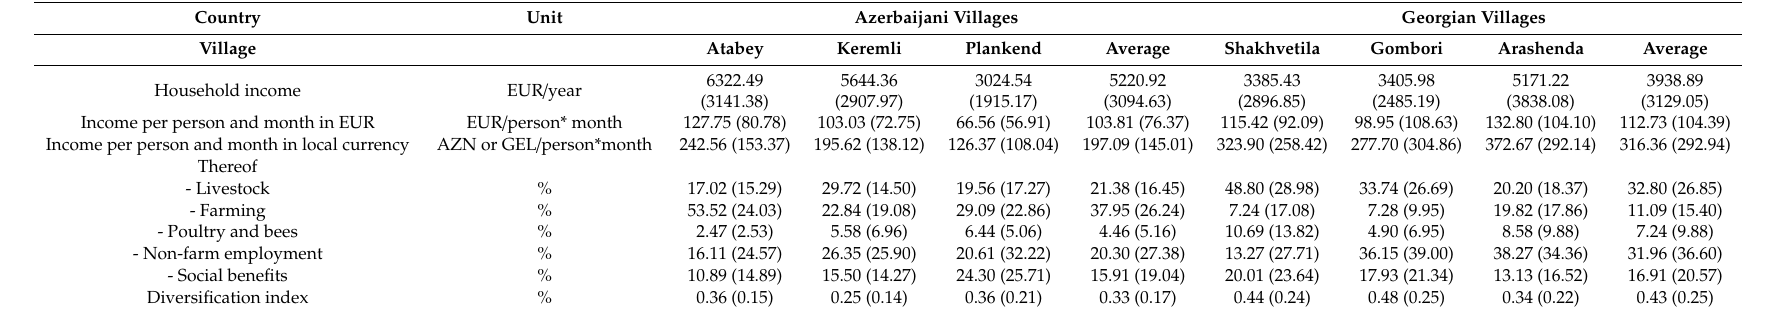
Table 5. Household income indicators, income composition and